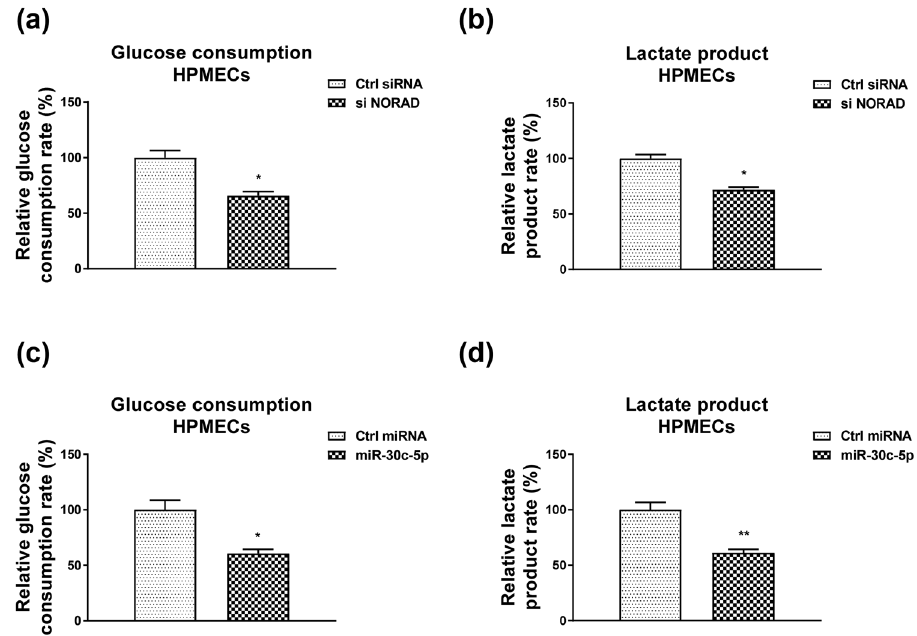
Figure 5: Invert roles of NORAD and miR - 30c - 5p in glycolysis. ( a ) The glucose consumption and ( b ) ECAR were examined in HPMECs without or with NORAD silencing. ( c ) The glucose consumption and ( d ) ECAR were examined in HPMECs without or with miR - 30c - 5p overexpression. *, p < 0.05; **, p < 0.01.